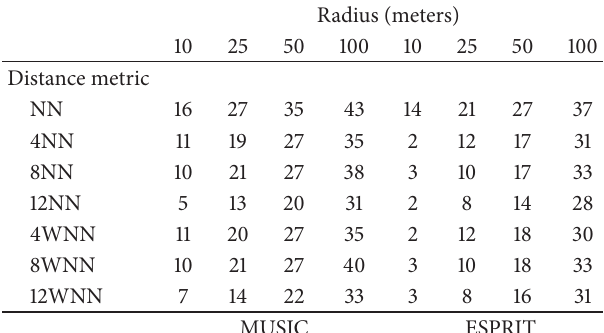
Table 6: Number of “hits” within given radius to actual location for each distance metric out of 100 trials. SNR = 0 dB; number of antennas = 8; oversampling factor = 2; distance-threshold = 0.2, Scenario B.